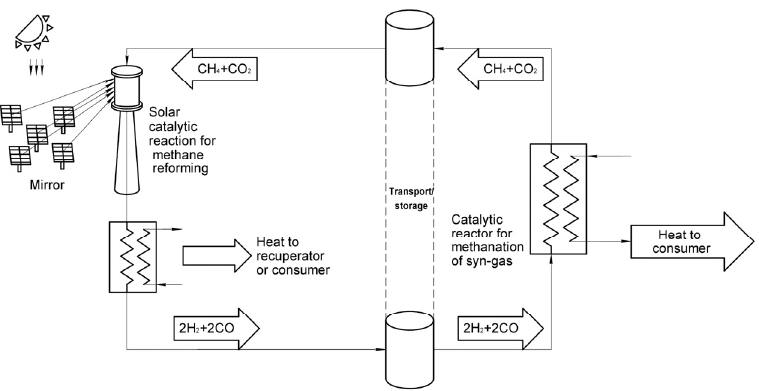
Figure 16. Thermochemical accumulation in a solar power plant.